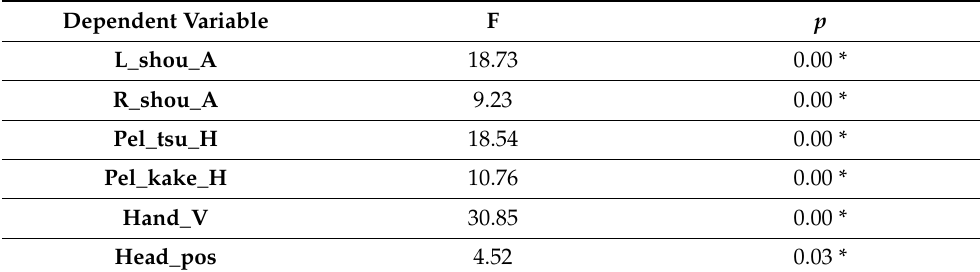
Table 4. Results of ANOVA for repeated measurements for a single